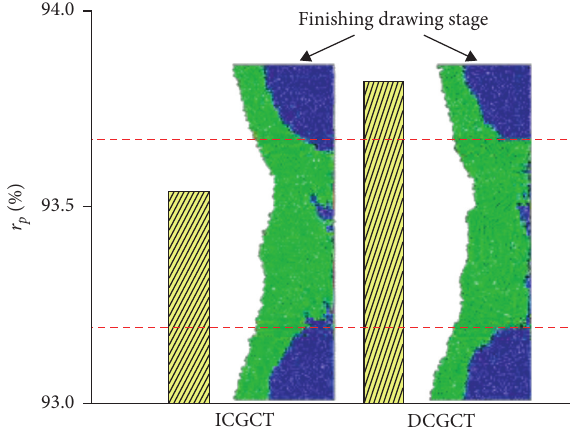
Figure 11: Comparison of drawing efficiency under ICGCT and